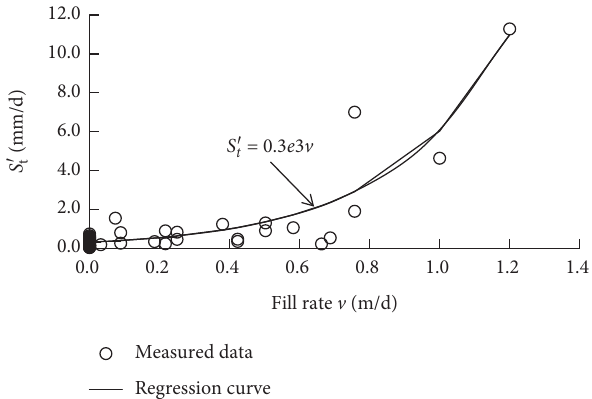
Figure 16: Relationship between PCS rate and fill rate of the platform at the fill slope.